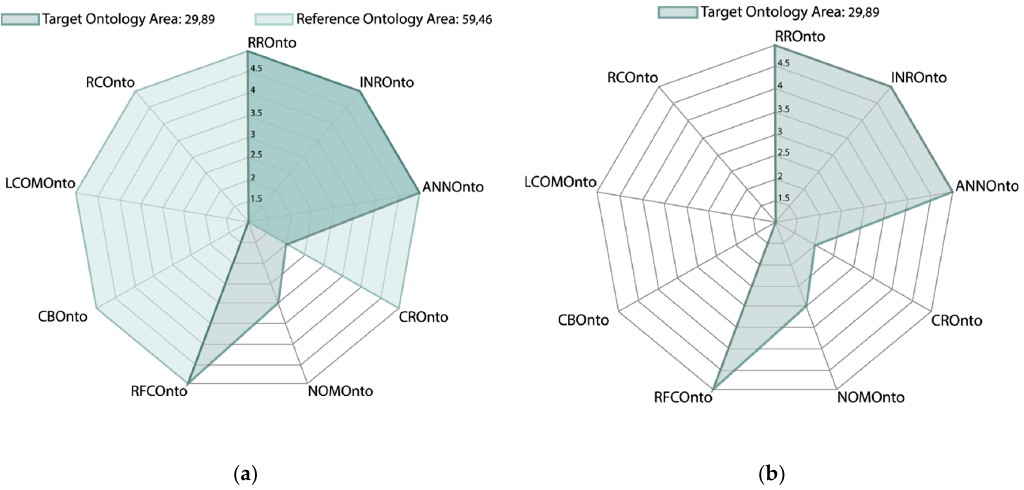
Figure 1. Ontology quality assessment result: ( a ) Quality comparison with a reference ontology, ( b ) ( b ) Quality evaluation of an Quality evaluation of an ontology .